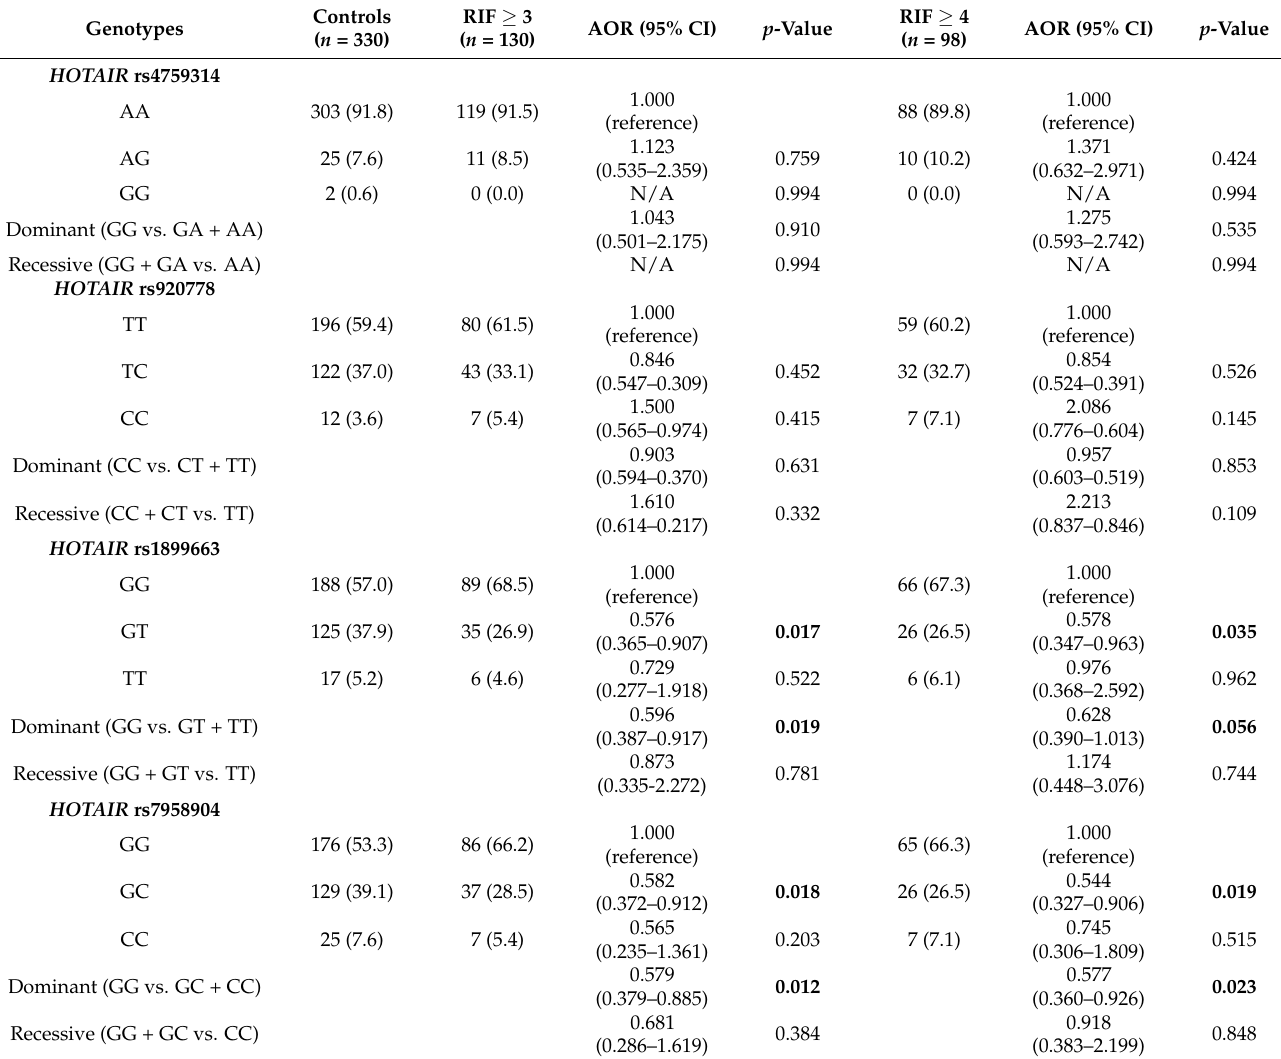
Table 3. Genotype frequencies for each polymorphism according to the number of